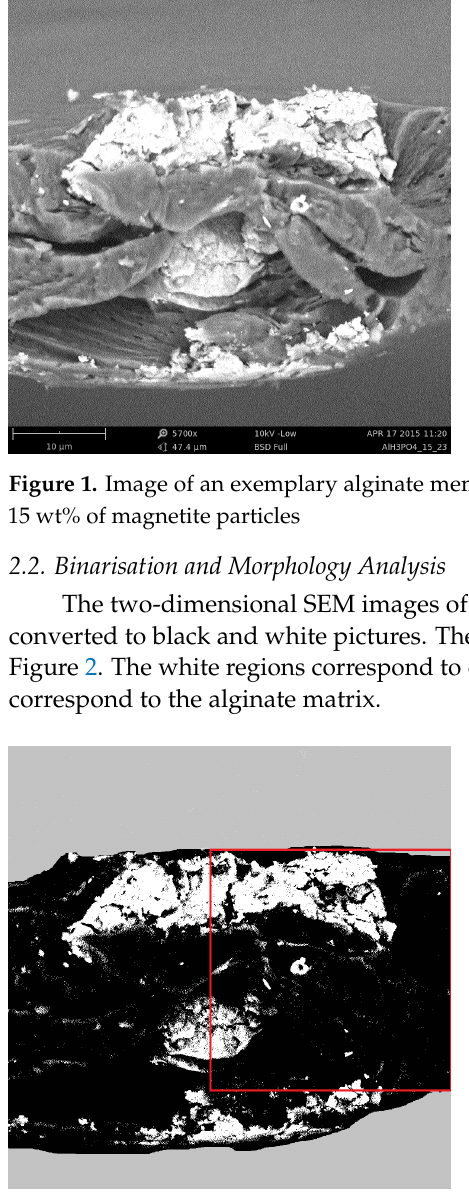
Figure 2. Image of exemplary alginate membrane, cross-linked by phosphoric acid, containing 15 wt% of magnetite particles-prepared for particle motion analysis. The area of 1024 × 1024 pixels used for further analysis is marked with a red